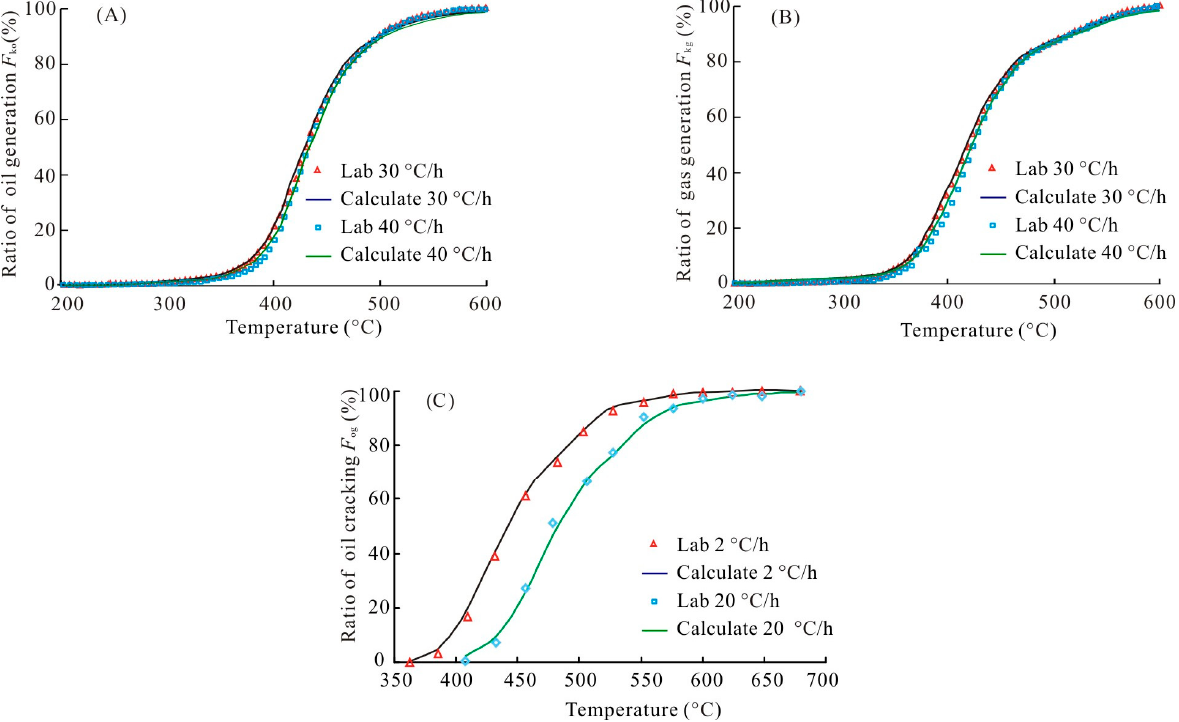
Figure 4. The conversion ratios of hydrocarbon generation from OM in thermal simulation experiments: ( A ) conversion ratio of oil generation from OM; ( B ) conversion ratio of gas generation from OM; ( C ) conversion ratio of gas generation from oil cracking.